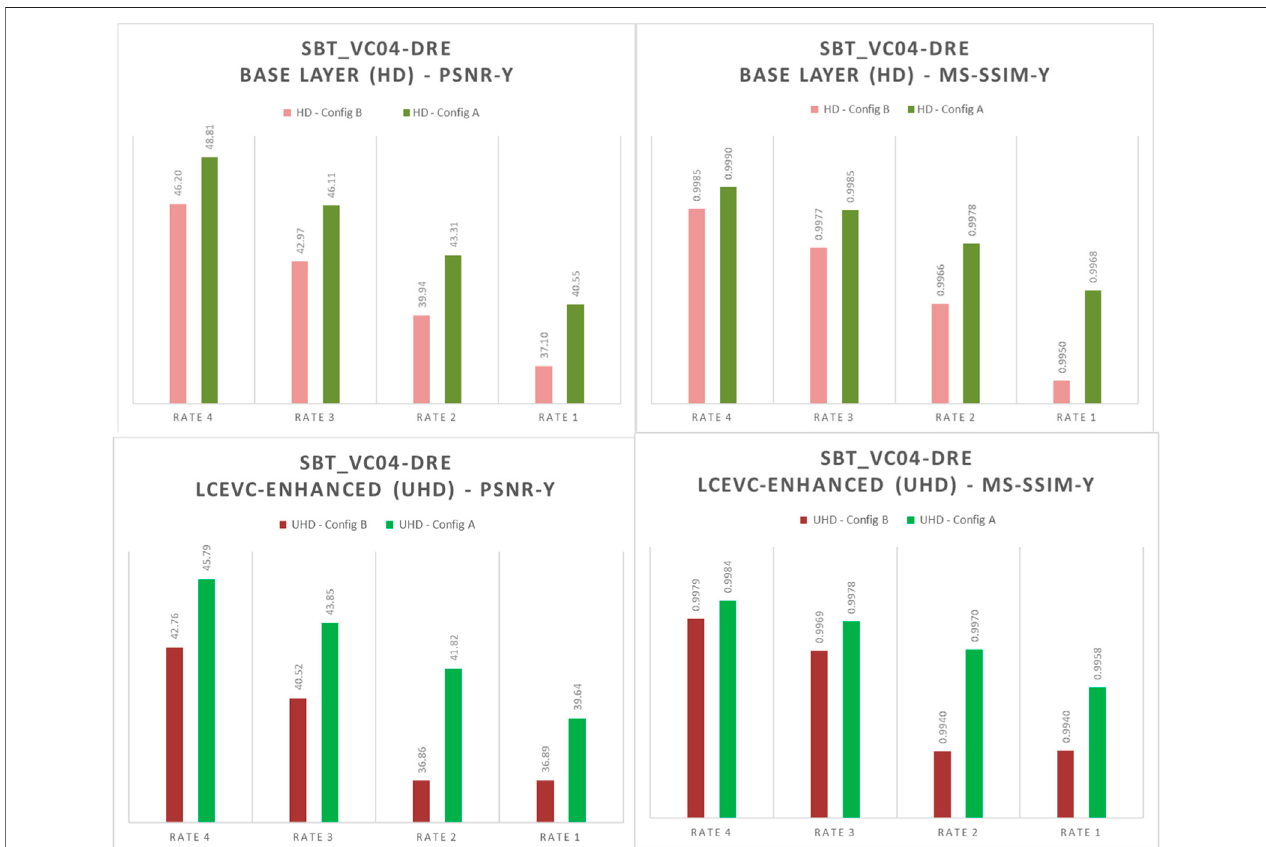
FIGURE 10 | Comparison of MS-SSIM-Y and PSNR-Y between the base layers (HD) under Con fi guration A (green) and Con fi guration B (red) – SBT_vc04- dre (HLG)